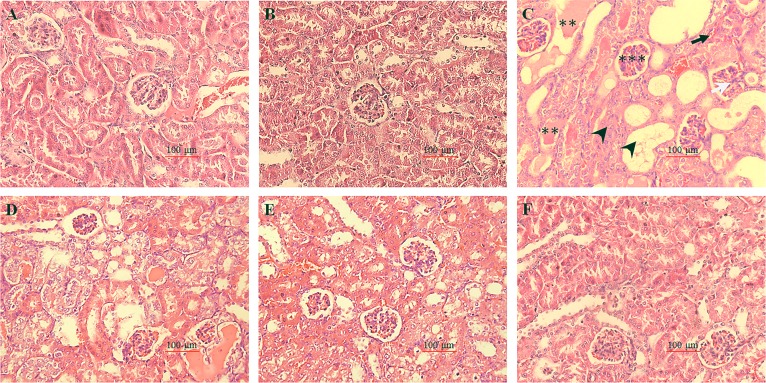
Photomicrographs of rat kidney sections stained with hematoxylin and eosin (H.E) (200×).(A) Kidney sections from control group showed normal morphological view; (B) Kidney tissues section from puerarin alone treated rats (50mg/kg) showed normal morphological view. (C) Kidney tissue section from cisplatin alone treated rats (7 mg/kg) showed severe tubular degeneration and necrosis, hyaline casts in the tubules, intertubular hemorrhage, congestion and swelling in glomerulus; (D-F) Sections from puerarin plus puerarin treated rats. The respective dose of puerarin was (D) 10mg/kg, (E) 30mg/kg and (F) 50 mg/kg. Kidney sections (F) from cisplatin plus 50mg/kg puerarin treated rats showed predominantly normal renal histology with occasional degenerative changes when compared with cisplatin alone treated rats. Black arrow head indicates necrosis and degeneration; Black arrow indicates intertubular hemorrhage; White arrow indicates leukocytes infiltration; Two asterisks indicate hyaline casts in the tubules. Three asterisks indicate congestion and swelling in glomerulus.